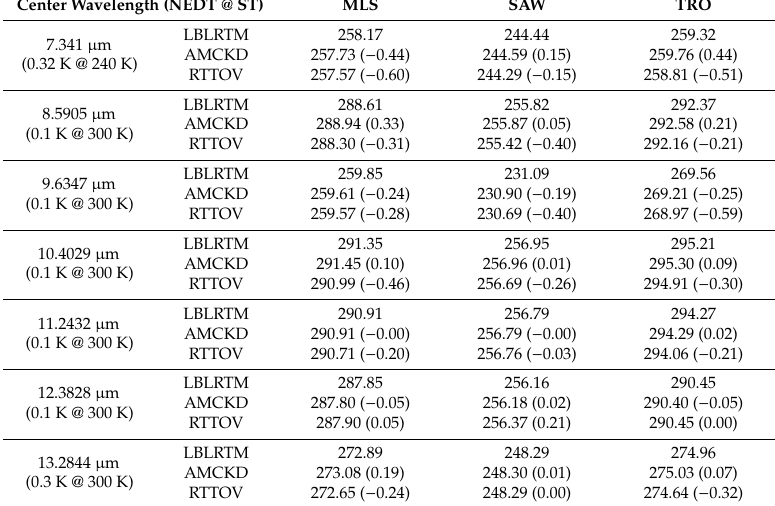
Table 1. Brightness temperatures at TOA for longwave channels calculated by LBLRTM, AMCKD, and RTTOV. The numbers shown in parentheses are the absolute errors (K) of brightness temperatures for longwave channels between each scheme and LBLRTM. The instrument noise equivalent temperature (NEDT) at scene temperature (ST) [32], indicating the tolerable noise range, is used as well in the comparisons. The satellite zenith angle is 45°. The mid-latitude summer (MLS), tropical (TRO) and sub-arctic winter (SAW) profiles are considered.